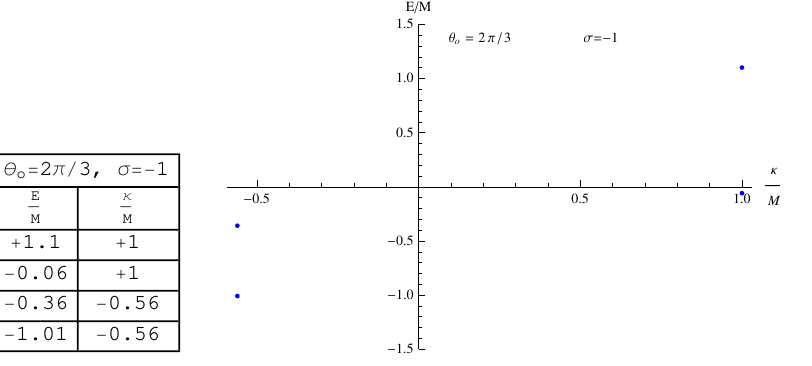
Figure 7 . The left table shows the E/M and κ/M values for θ 0 = 2 π/ 3 , σ = − 1 .The right figure shows the points with coordinates ( κ/M , E/M ) . Notice the BIC states for E = − 1 . 01 M, +1 . 1 M . The remaining components ξ ( a = 3 , 4) can be obtained from the above expressions a